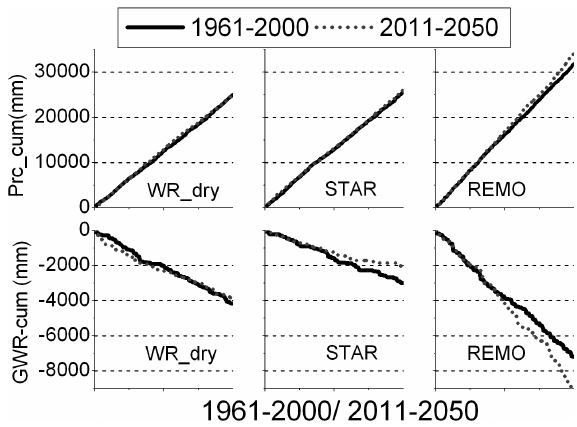
Fig. 8. Comparison of cumulative rates of daily precipitation (=Prc cum) and simulated groundwater recharge (=GWR cum) for the control period 1961–2000 and the defined climate change period 2011–2050 at the selected hydrotope with coniferous forest/sandy soil, simulated using the climate change scenarios WettReg dry (=WR dry), STAR and